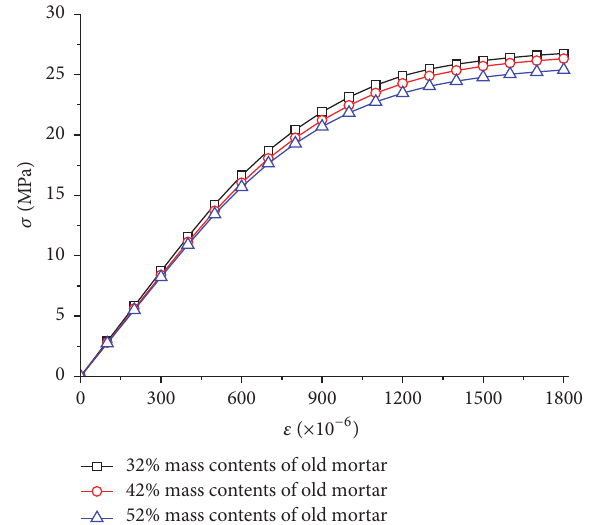
Figure 10: Uniaxial compressive stress-strain curve of RAC speci- mens with different mass contents of old mortar.